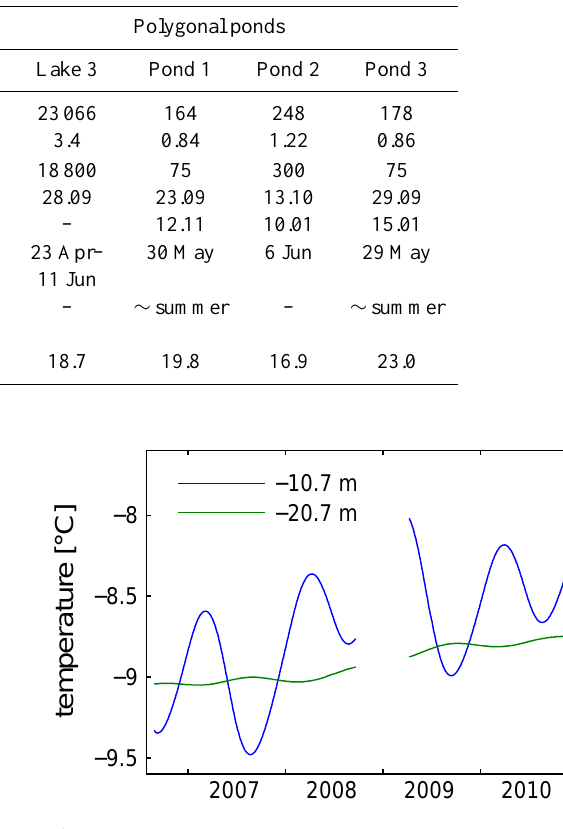
Table 7. Comparison between polygonal ponds and thermokarst lakes.